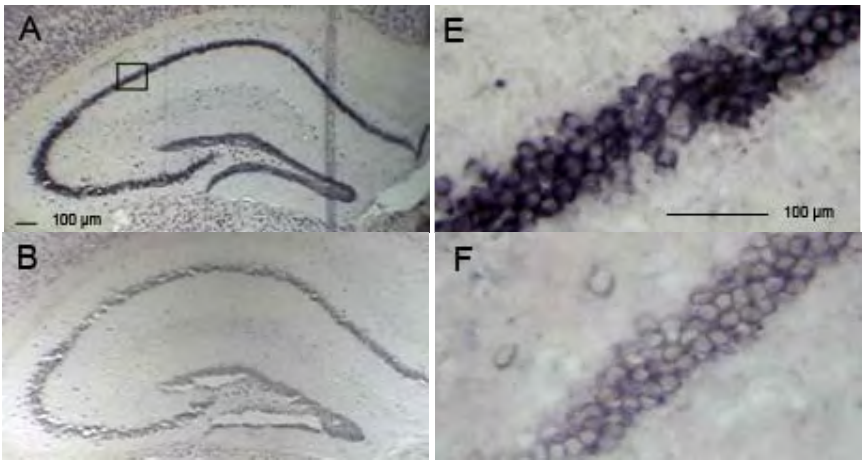
Figure 4. Effects of daidzein on the expression levels of bax mRNA assessed by non-radioactive in situ hybridization in D-gal-treated mice hippocampus. (A) Aging control. (B) Vehicle control. (C) Da-10 group. (D) Da-5